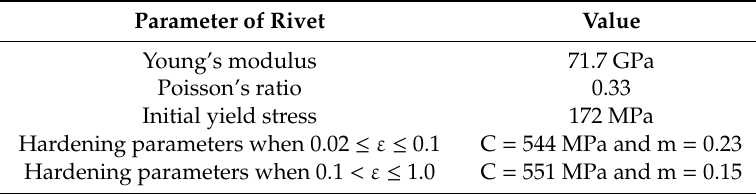
Table 3. Material properties for 2117-T4 aluminum alloy YSA621-100 ◦ rivet